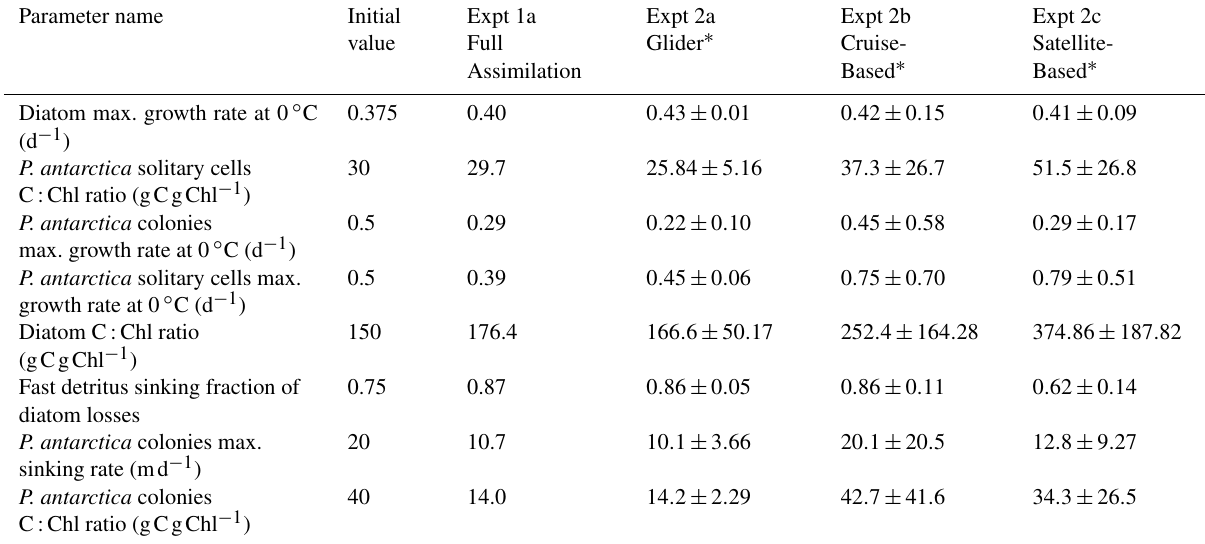
Table 4. Initial parameter values (No Assimilation) and optimal parameter values after conducting the Full Assimilation, Glider Assimilation, Cruise-Based Assimilation, and Satellite-Based Assimilation